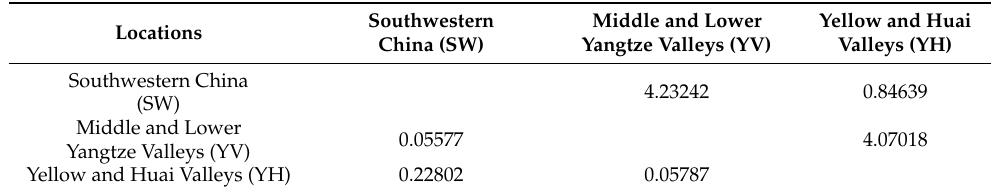
Table 7. Pairwise F ST (below diagonal) and gene flow N m (above diagonal) among different geo- graphic regions of P. tectus based on mitochondrial.